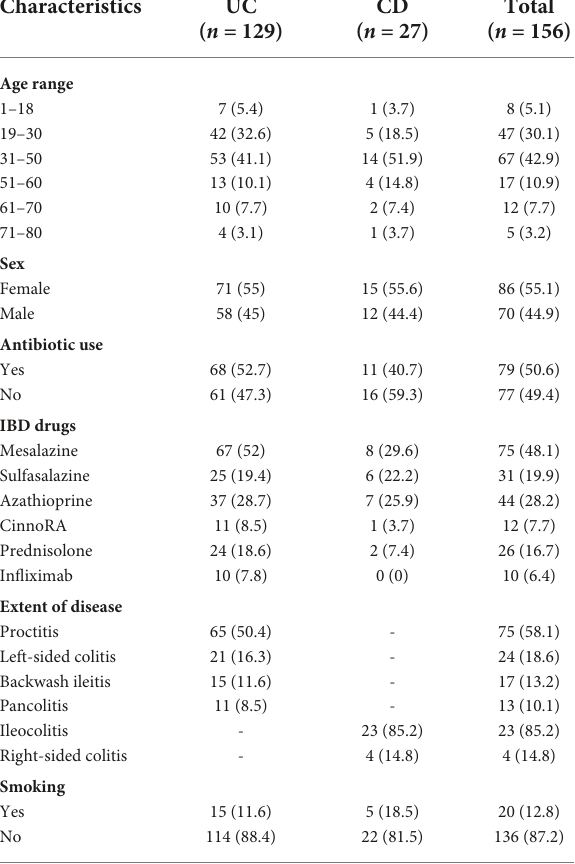
TABLE 2 Antimicrobial resistance profile (including resistant and intermediate) of the IBD-associated E. coli isolates according to the type of the